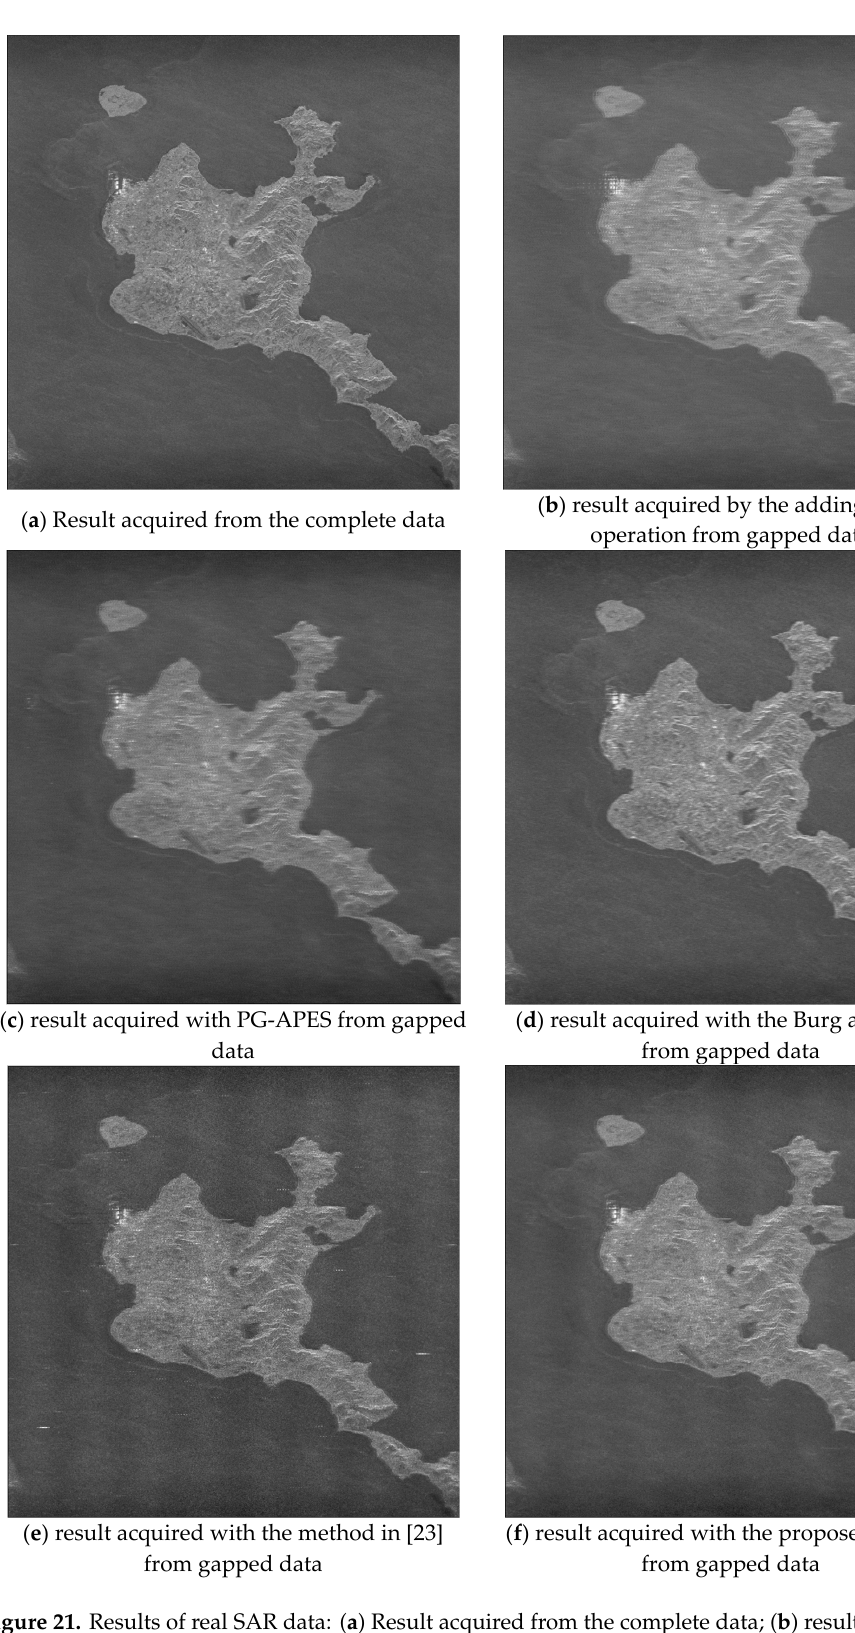
Figure 21. Results of real SAR data: ( a ) Result acquired from the complete data; ( b ) result acquired by the adding zeros operation from gapped data; ( c ) result acquired with PG-APES from gapped data; ( d ) result acquired with the Burg algorithm from gapped data; ( e ) result acquired with the method in [23] from gapped data; and ( f ) result acquired with the proposed method from gapped